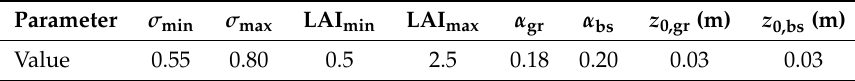
Table 1. Main land surface parameter values in TERRA representing the Falkenberg site. σ min and σ max are the minimum and maximum vegetation ratio, representing grass at rest and during the growing season. LAI min and LAI max are the respective values but for the leaf area index. The transitions between these values in spring and autumn are prescribed by a sinusoidal fit. α gr and α bs are the surface albedos for grass and bare soil, and z 0,gr and z 0,bs are the turbulent roughness lengths for grass and bare soil,